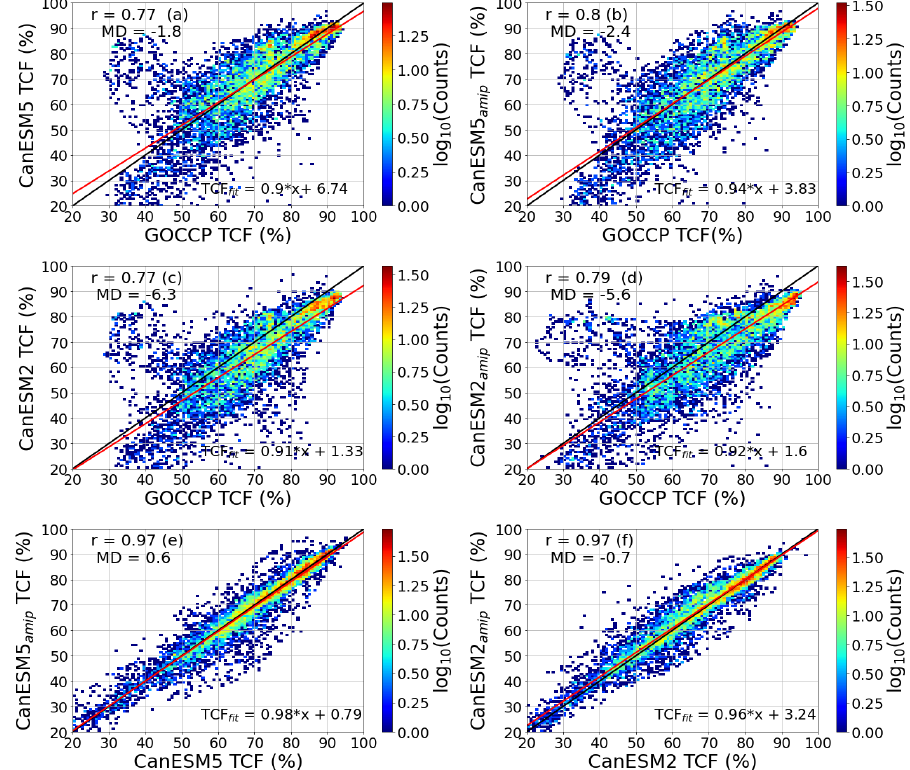
Figure 1. The 2D density plots of monthly averaged total cloud fraction (TCF) based on the GOCCP and model data (CanESM5 ( a ), CanESM5 amip ( b ), CanESM2 ( c ), CanESM2 amip ( d )), and based on model data (CanESM5 amip and CanESM5 ( e ); CanESM2 amip and CanESM2 ( f )). The red solid lines represent the best-fit equations (x represents the variable on the x -axis) and the solid black line represents the 1:1 line. The correlation coefficients (r) and the mean difference (MD) values are given.